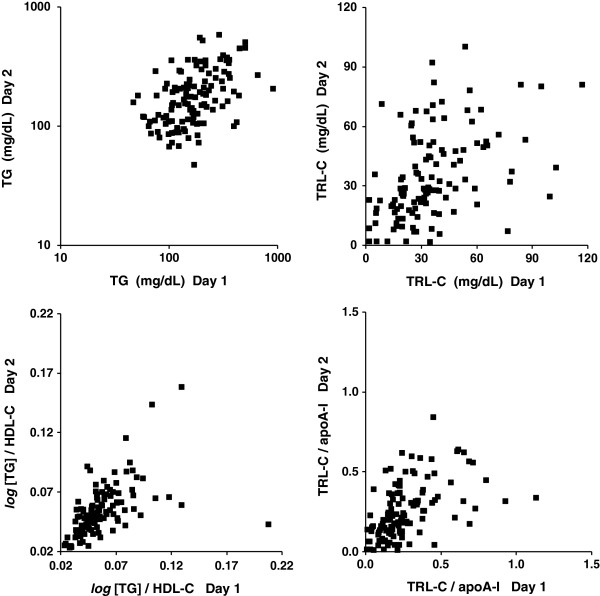
Plots of untransformed values obtained on day 1 (
X axis
) and day 2 (
Y axis
) for nonfasting triglycerides (TG) (
upper left
); TG-rich lipoprotein cholesterol (TRL-C) (
upper right
); nonfasting
log
[TG]/high-density lipoprotein cholesterol (HDL-C) (
lower left
); and TRL-C/apolipoprotein (apo) A-I (
lower right
) in 120 patients with type 2 diabetes.